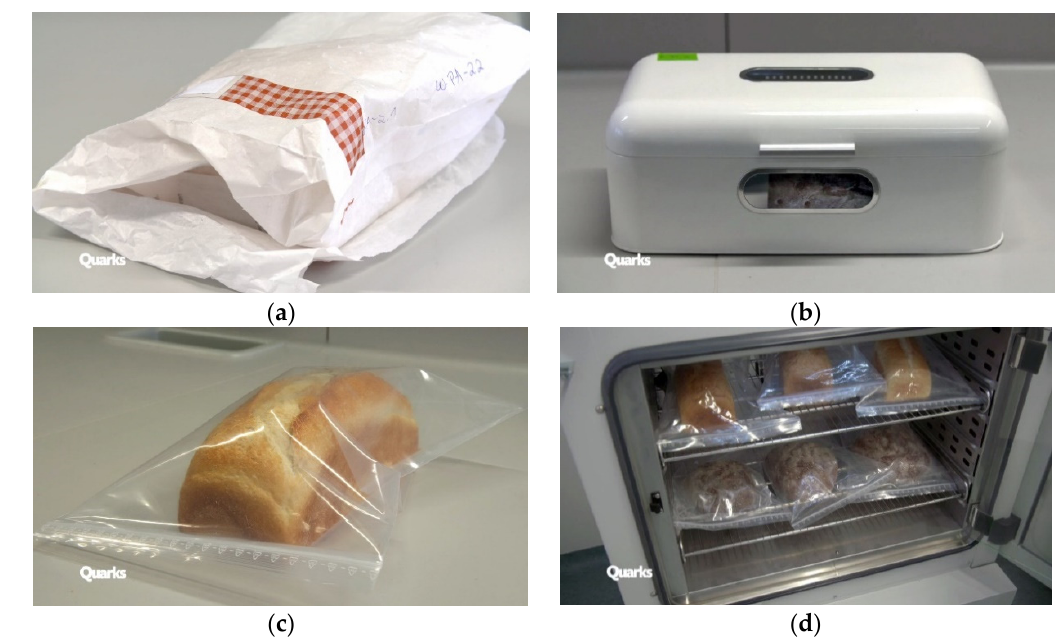
Figure A1. Exemplary presentation of the storage setup. The bread loaves were stored in four different common storage methods. ( a ) Bread loaf stored in a PE-layered microperforated paper bag (21.3 ± 0.4 °C). ( b ) Mixed-type sourdough bread stored in a bread box with 13 little ventilation holes on the back side (22.0 ± 0.5 °C). ( c ) Pan wheat bread stored in a plastic bag at room temperature (21.9 ± 0.5 °C). ( d ) Pan wheat bread and mixed-type sourdough bread stored in plastic bags at fridge temperature (8.2 ± 0.2 °C). © WDR (Westdeutscher